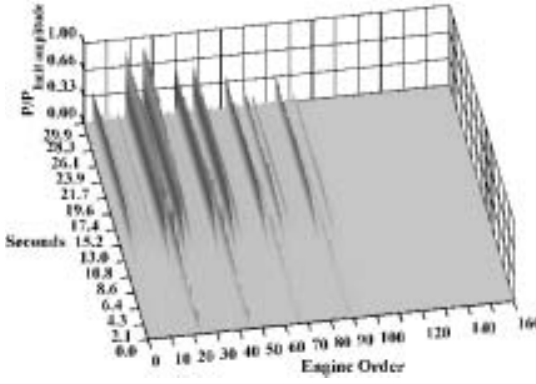
Fig. 5. Successive Fourier transforms of pressure transducer 11 as the fan is back-pressured into